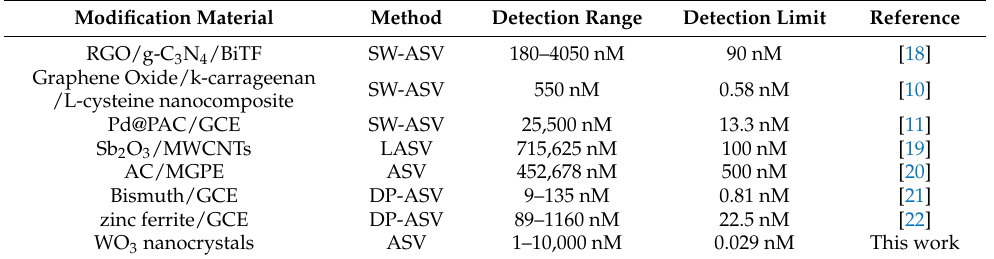
Table 1. Comparison of Cd 2+ -detection performance of electrodes modified with different